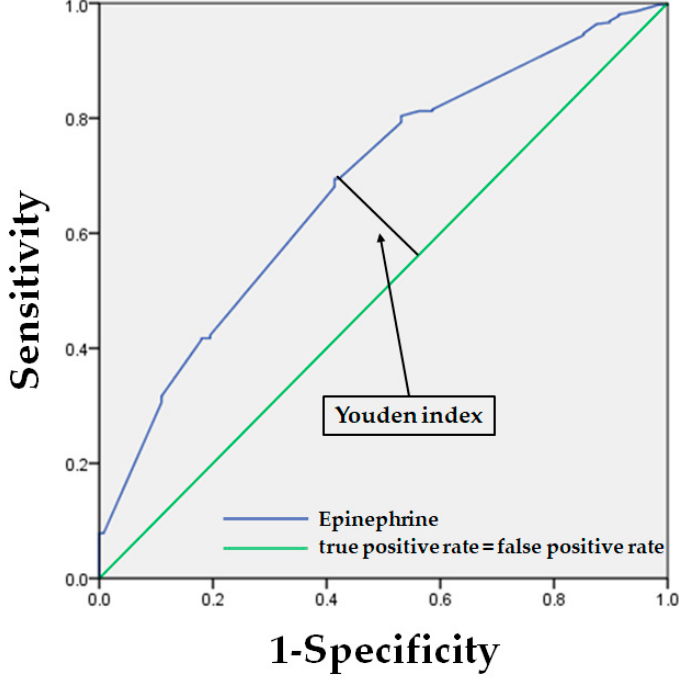
Figure 3. Receiver operating characteristic curves representing epinephrine cut-off value with Youden index.